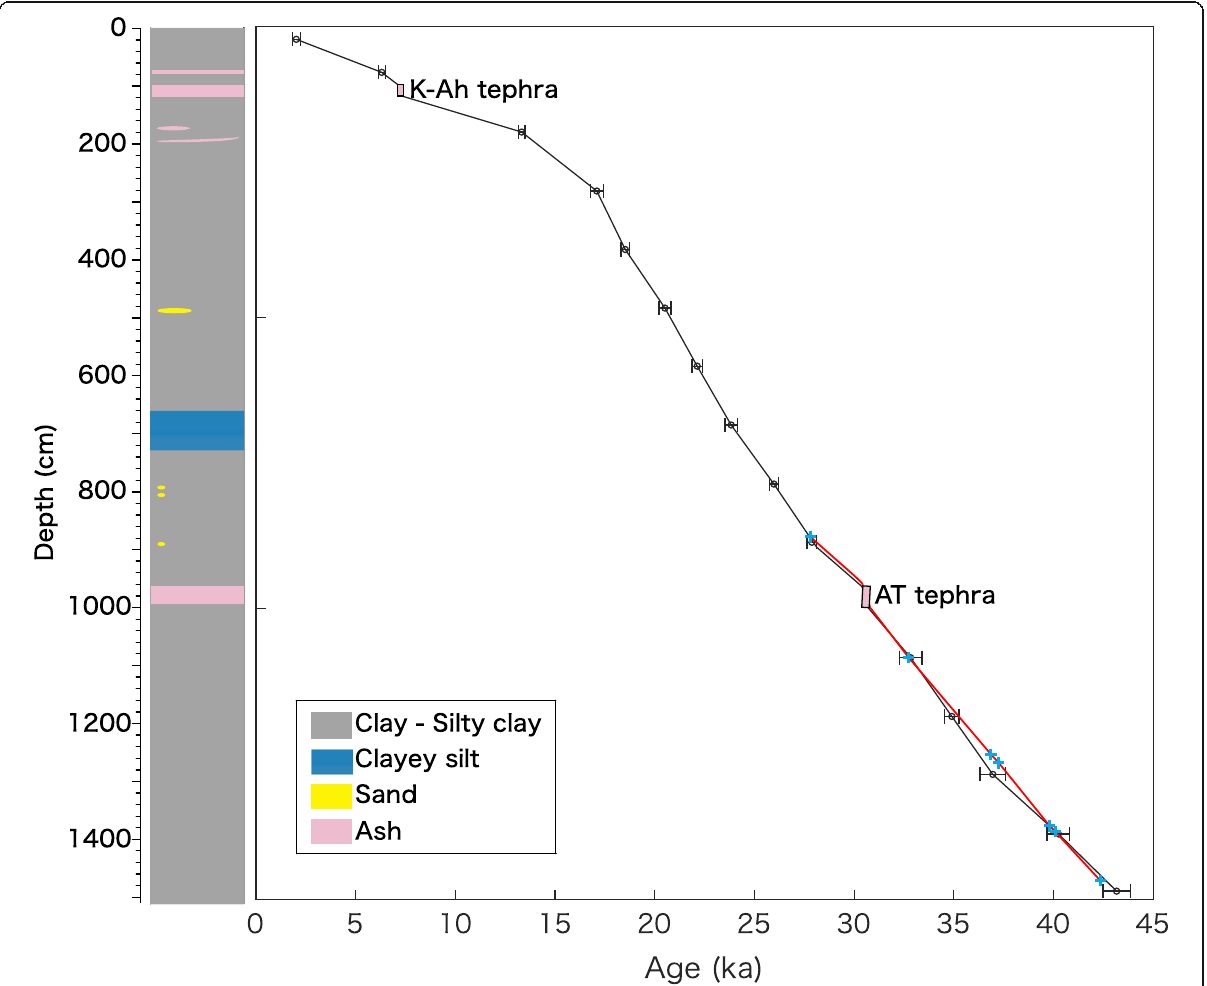
Fig. 2 Age-depth relationship of core KR07-12 PC-01 together with 2 σ age uncertainties and columnar section. The black circles and lines represent 14 C-based datum and its age model. The red line indicates the fine-tuned age model. The blue crosses represent the tie points in the fine- tuned age